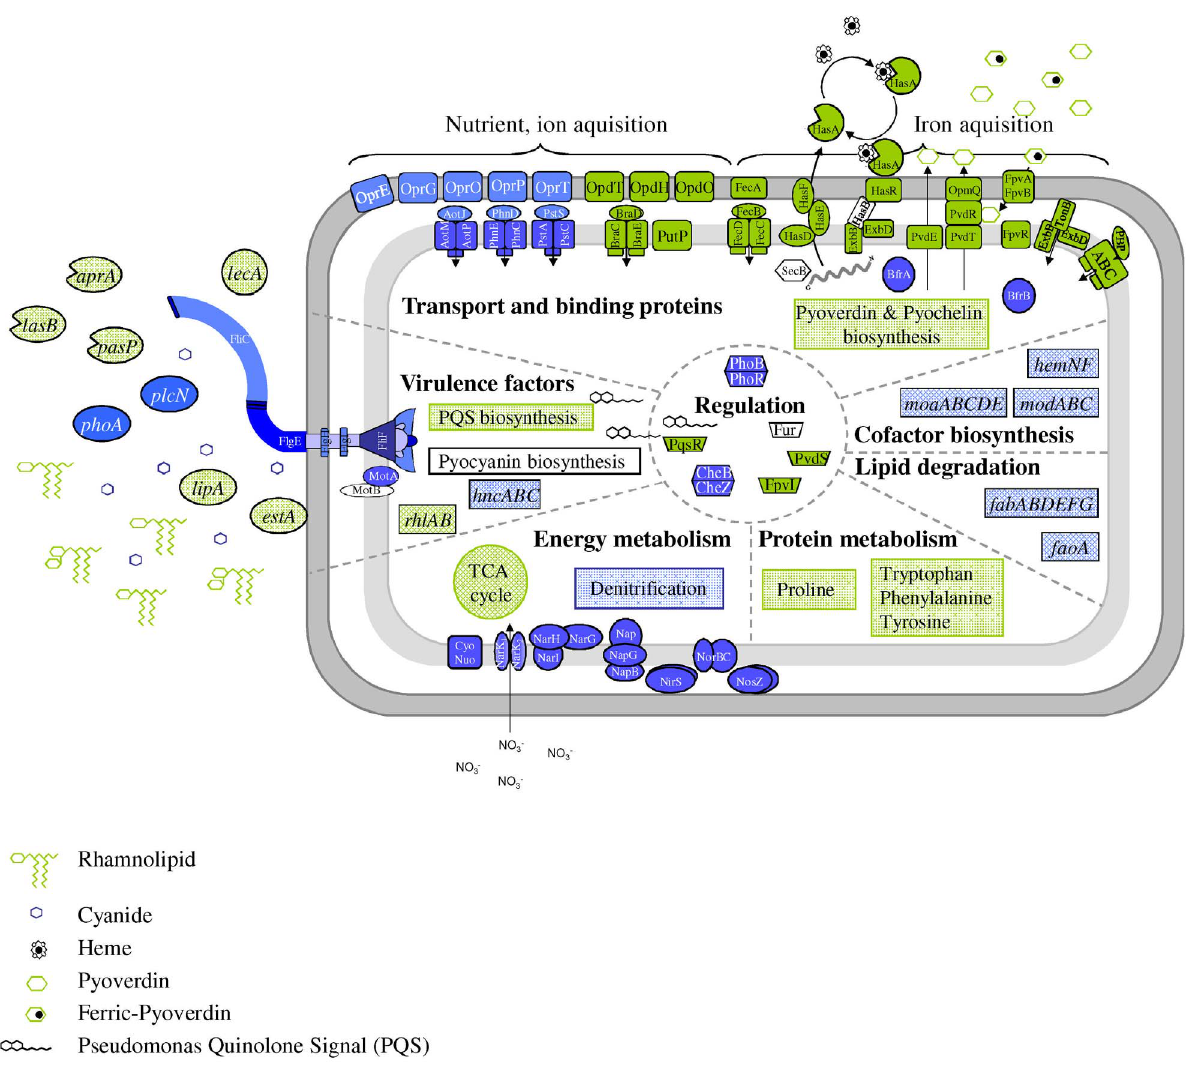
Figure 6. Regulatory and metabolic networks for the adaptation of P.aeruginosa to the anaerobic conditions in the urinary tract. The model presents the transcriptional, proteomic and metabolic response of P. aeruginosa grown under anaerobic conditions as colony biofilms on AUM. Transcriptome, proteome and metabolome analyses were performed as outlined in the text. Obtained data were integrated into the shown scheme. Expression of genes, protein concentration or pathways found induced (green), reduced (blue) or not differently expressed (white) in biofilms grown on AUM are shown.